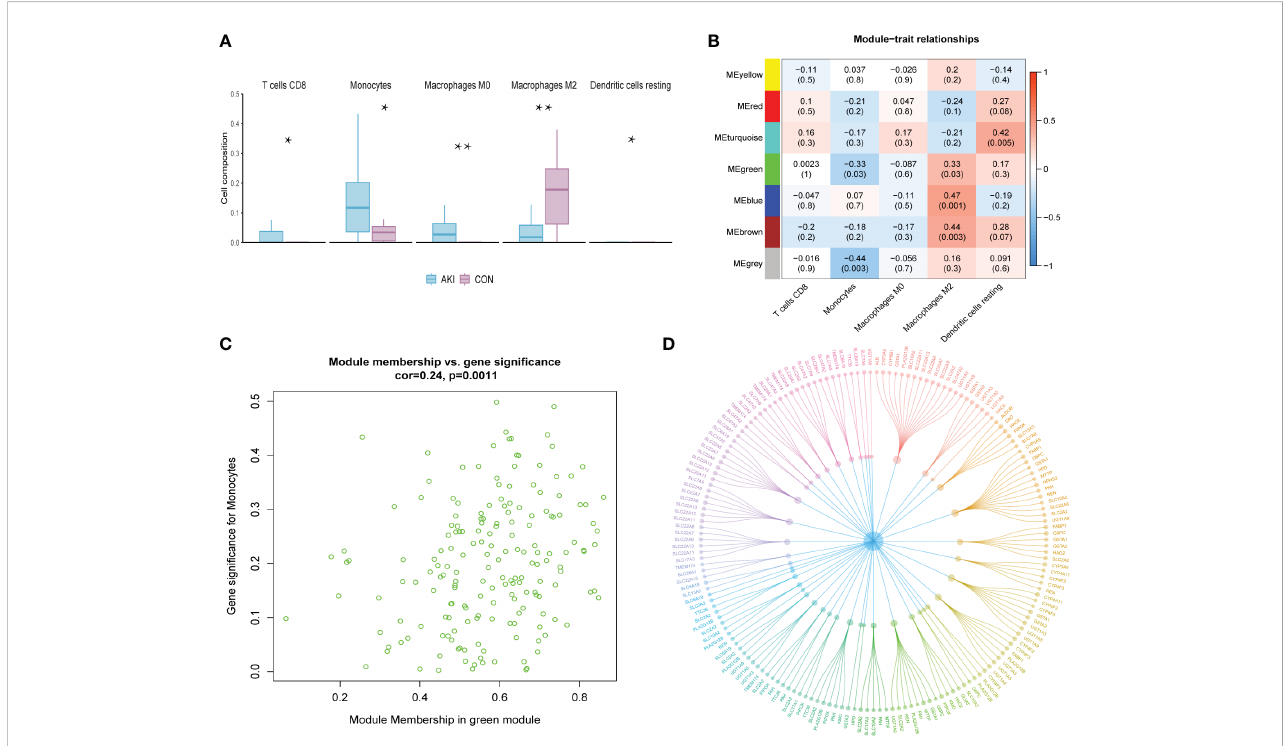
GSEA of the target gene The samples in the dataset GSE139061 were divided into the high- group and low-expression groups according to the median expression of AFM . The pathway enrichment analysis identi fi ed 118